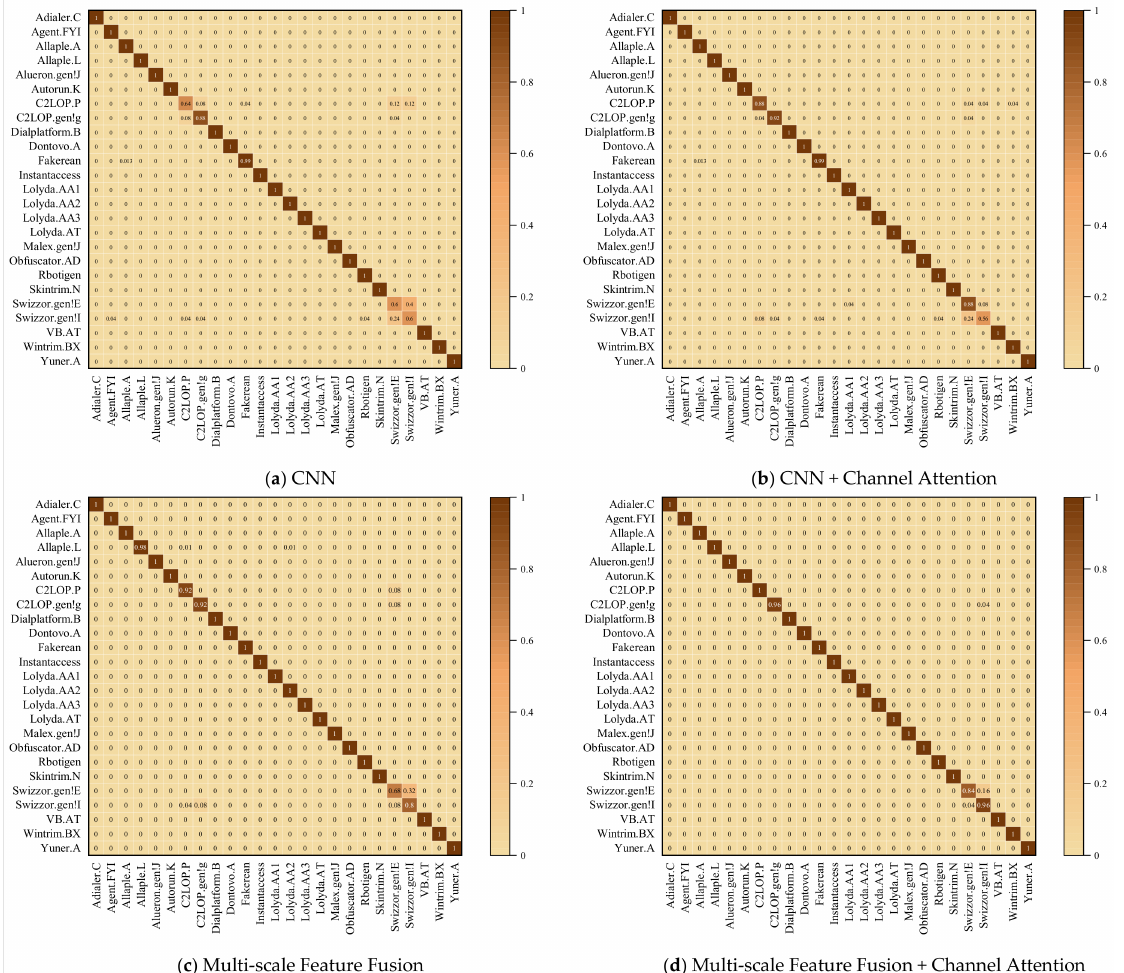
Figure 9. Confusion matrixes for each